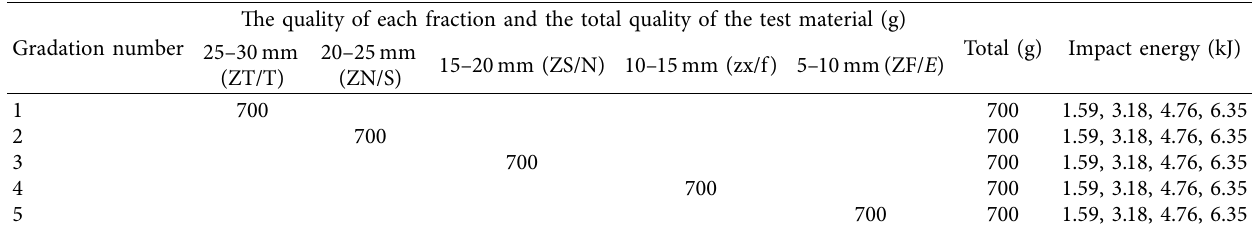
Figure 8: Fitting relation curve of single-particle strength representative value with 95% guarantee rate of different materials. Table 2: Test sample grading and cumulative impact energy